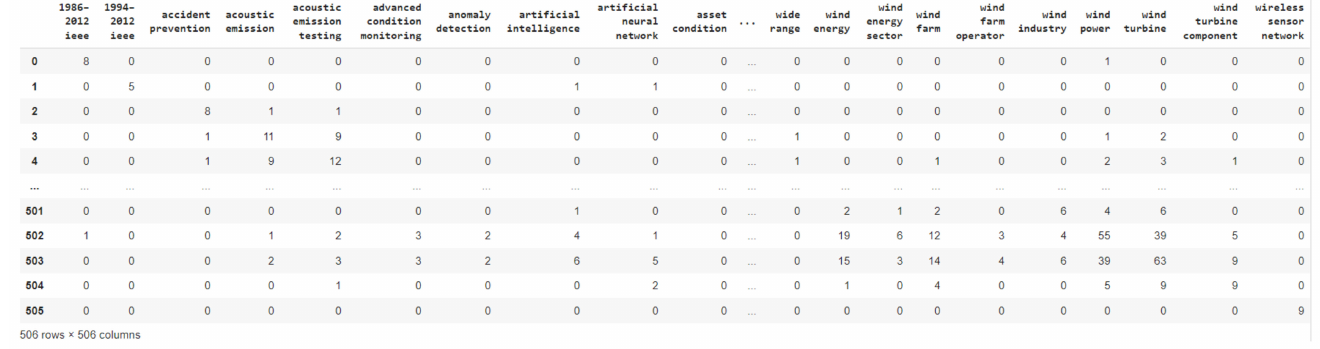
Figure 3. The keyword co-occurrence matrix W